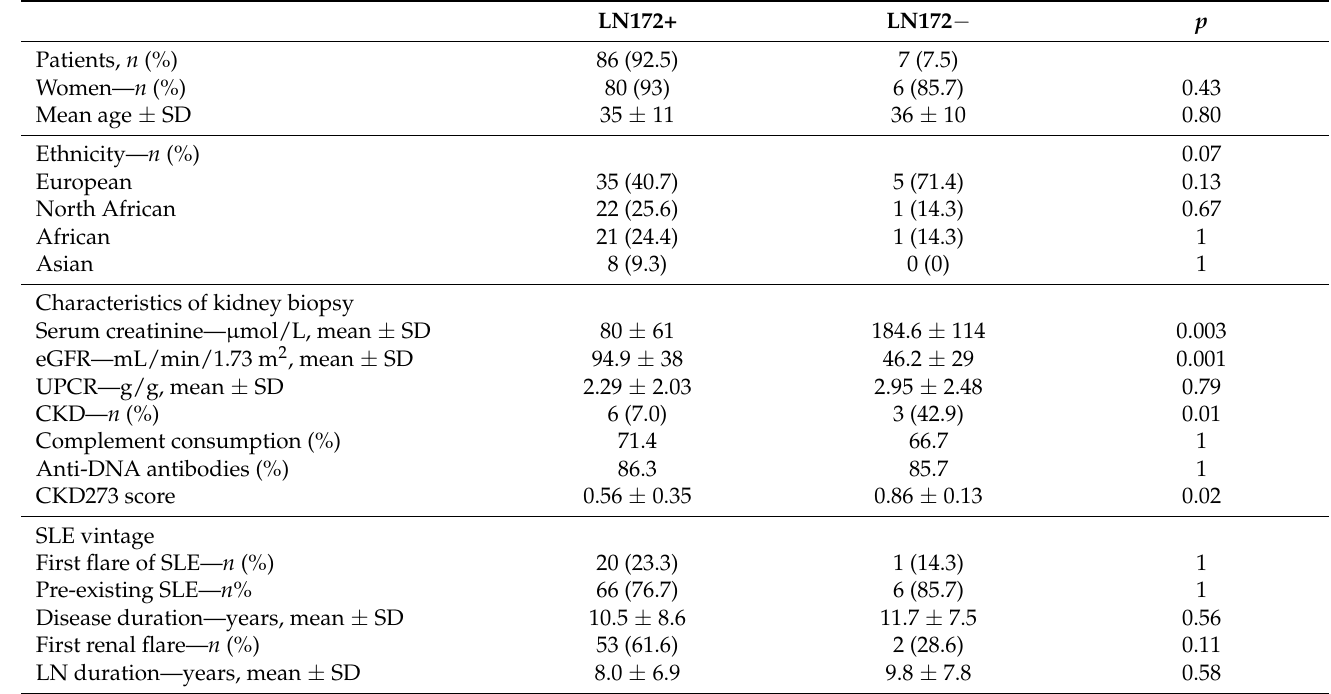
Table A2. Characteristics of patients according to their classification with the LN172